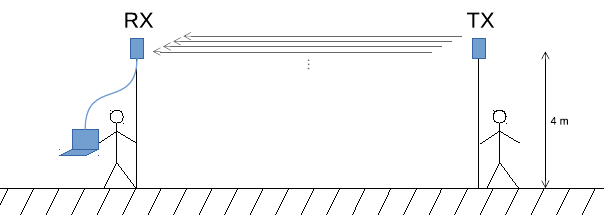
Figure 6. Setup for range